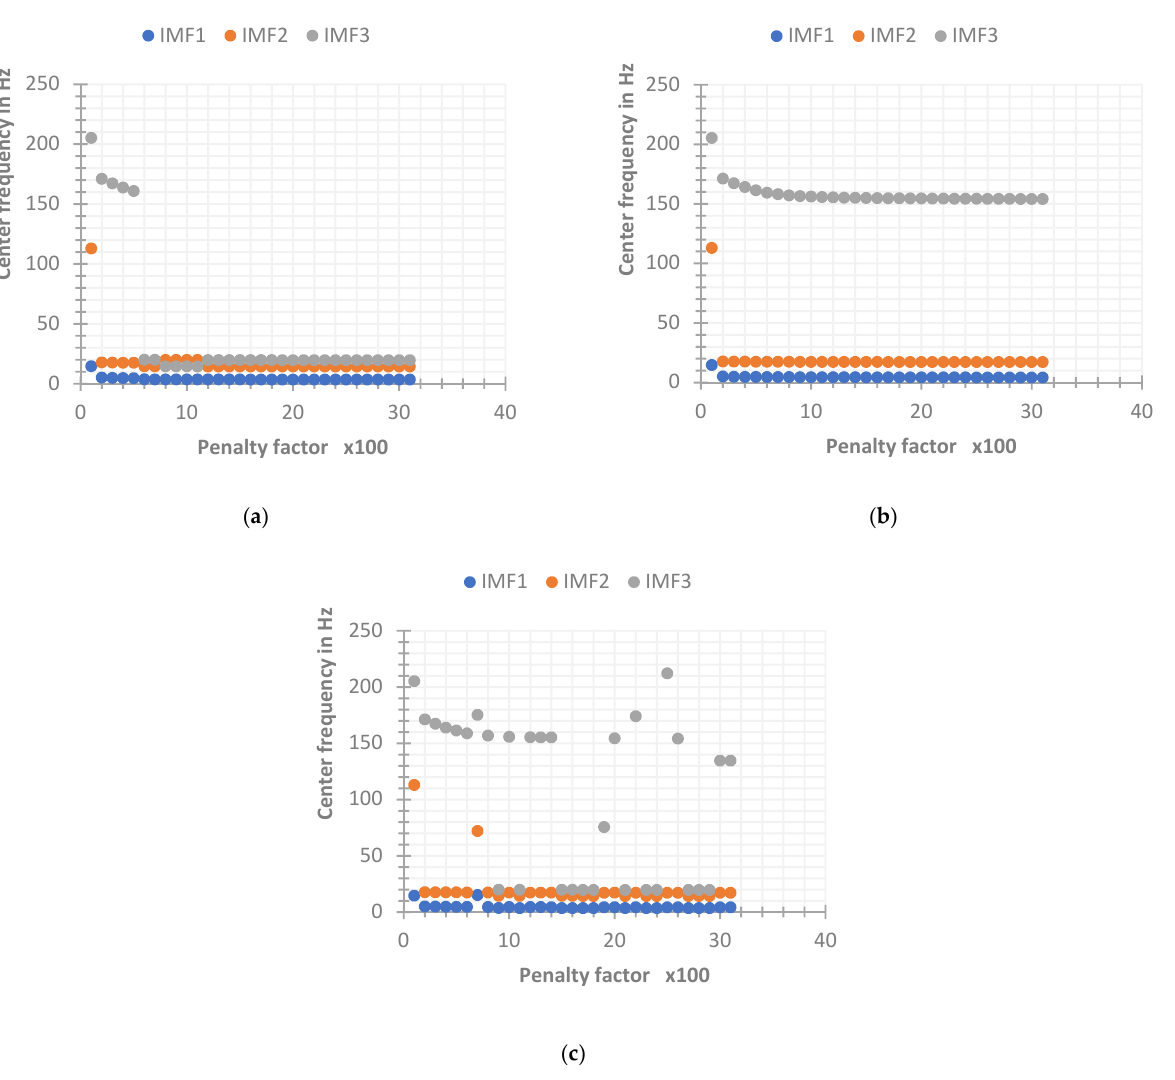
Figure 11. Convergence frequency of different initial center frequency setting methods under 6 dB. ( a ) SNR = 6 dB, the initial center frequency is set to zero. ( b ) SNR = 6 dB, the initial center frequency is set to fixed. ( c ) SNR = 6 dB, the initial center frequency is set to random.